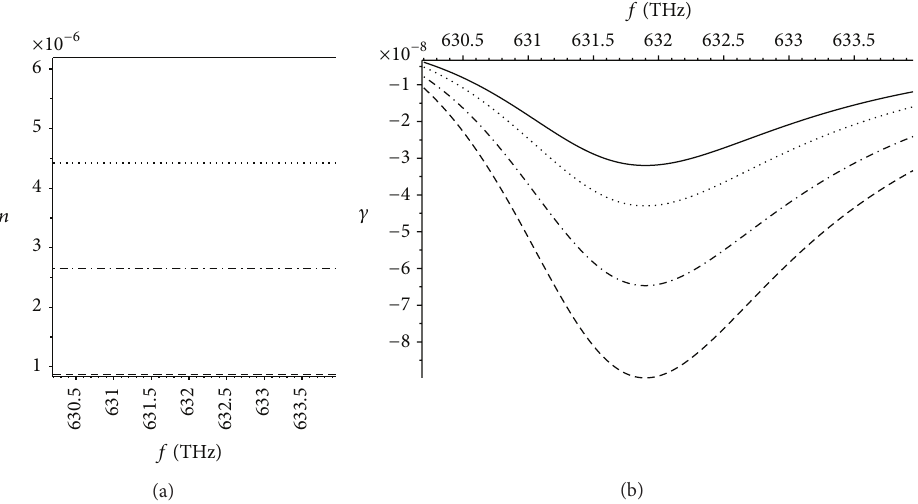
Figure7:(a)Therealpartoftheeffectiverefractiveindex, 𝑛 ,versusthefrequencyforTE 𝑚 , 𝑚 = 0, 1,2, 3 .(b)Theimaginarypartoftheeffective refractive index (the extinction coefficient), 𝛾 , versus the frequency for same set of modes. Note that 𝑚 = 0 (dash), 𝑚 = 1 (dot-dashed), 𝑚 = 2 (dotted), and 𝑚 = 3 (solid).